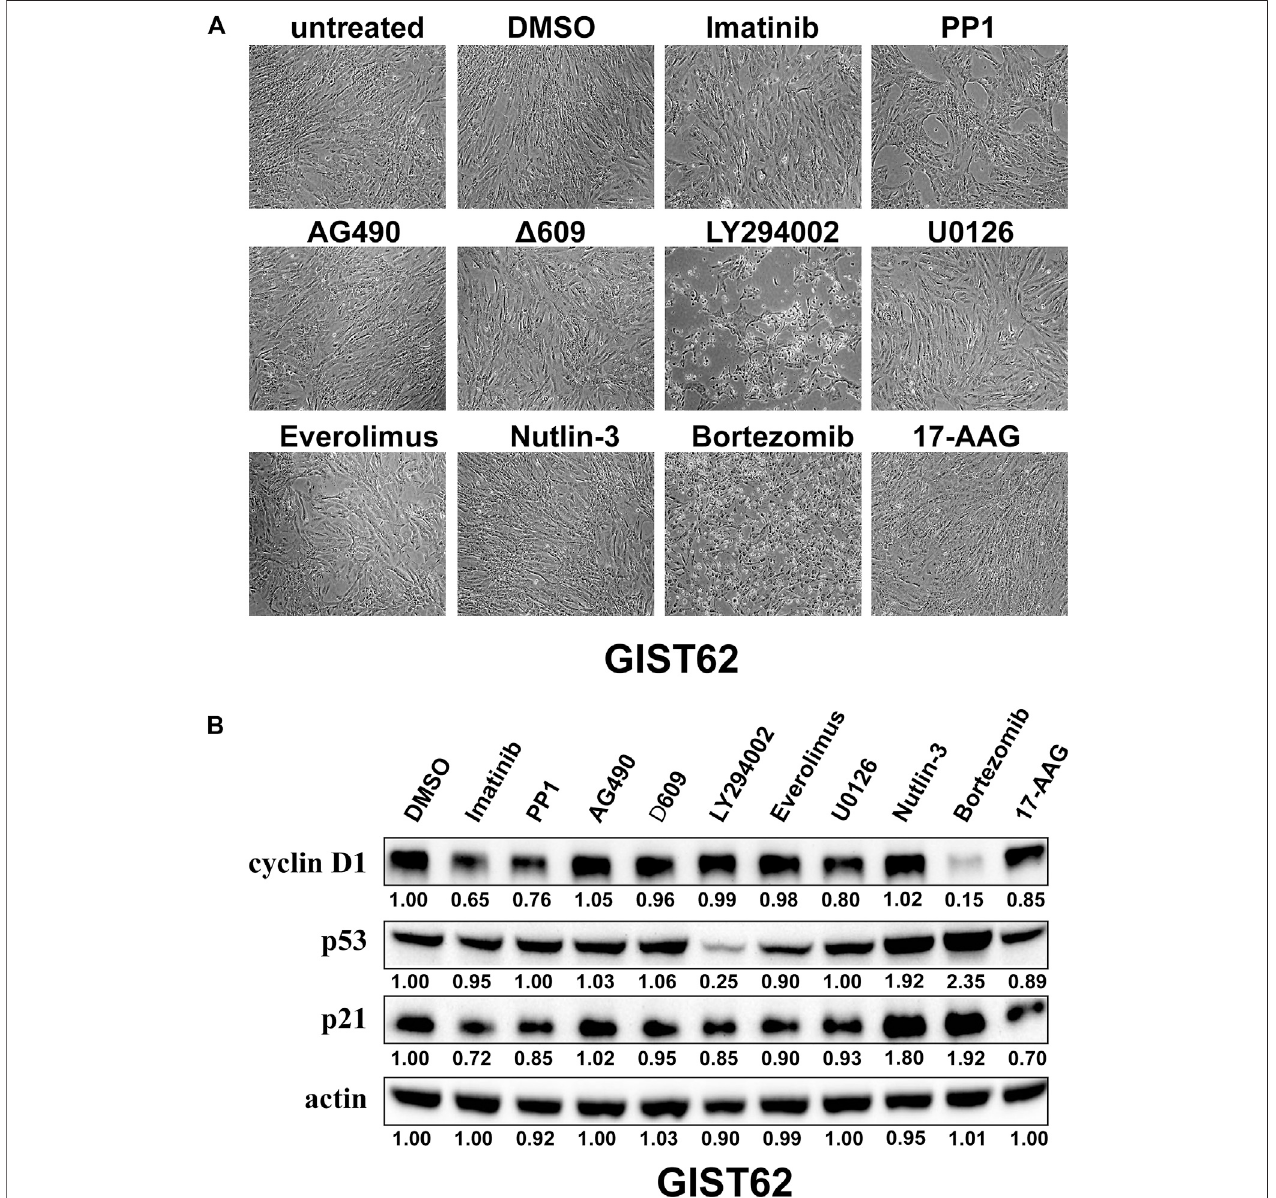
FIGURE 1 | (A) Cell growth was evaluated in KIT-independent GIST cell line ( GIST62) after treatment with Imatinib (1 μ M), PP1 (1 μ M), AG490 (10 μ M), Δ 609 (1 μ M), LY294002 (50 μ M), U0126 (10 μ M), Everolimus (1 μ M), Nutlin-3 (5 μ M), Bortezomib (100 nM), and 17-AAG (0.5 μ M) for 72 h. (B) Immunoblotting evaluated expression of cyclin D1, p53, and p21 in GIST62 cells after treatment with the bortezomib for 72 h. Actin stain is a loading control. Linear capture quantitation of immunoblotting chemiluminescence signals, using an ImageQuant LAS4000. Intensity values are standardized to the DMSO control.